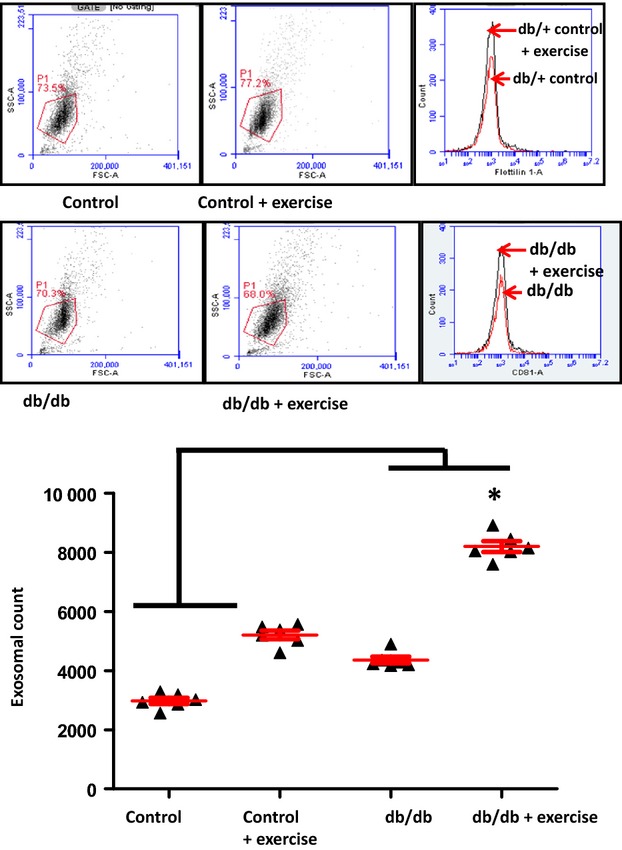
Quantitative estimation of exosomes by flow cytometry. The exosomes were quantitated by using Dyna beads from Life Technologies according to the manufacturer’s protocol. The Dyna beads were incubated with the primary antibodies followed by incubation with the exosomal fraction. The Dyna beads containing the exosomes were subjected to flow cytometry and we observed that there was significant increase in the number of exosomes in the exercise group as compared to the non-exercise (*P < 0.05), n = 6.